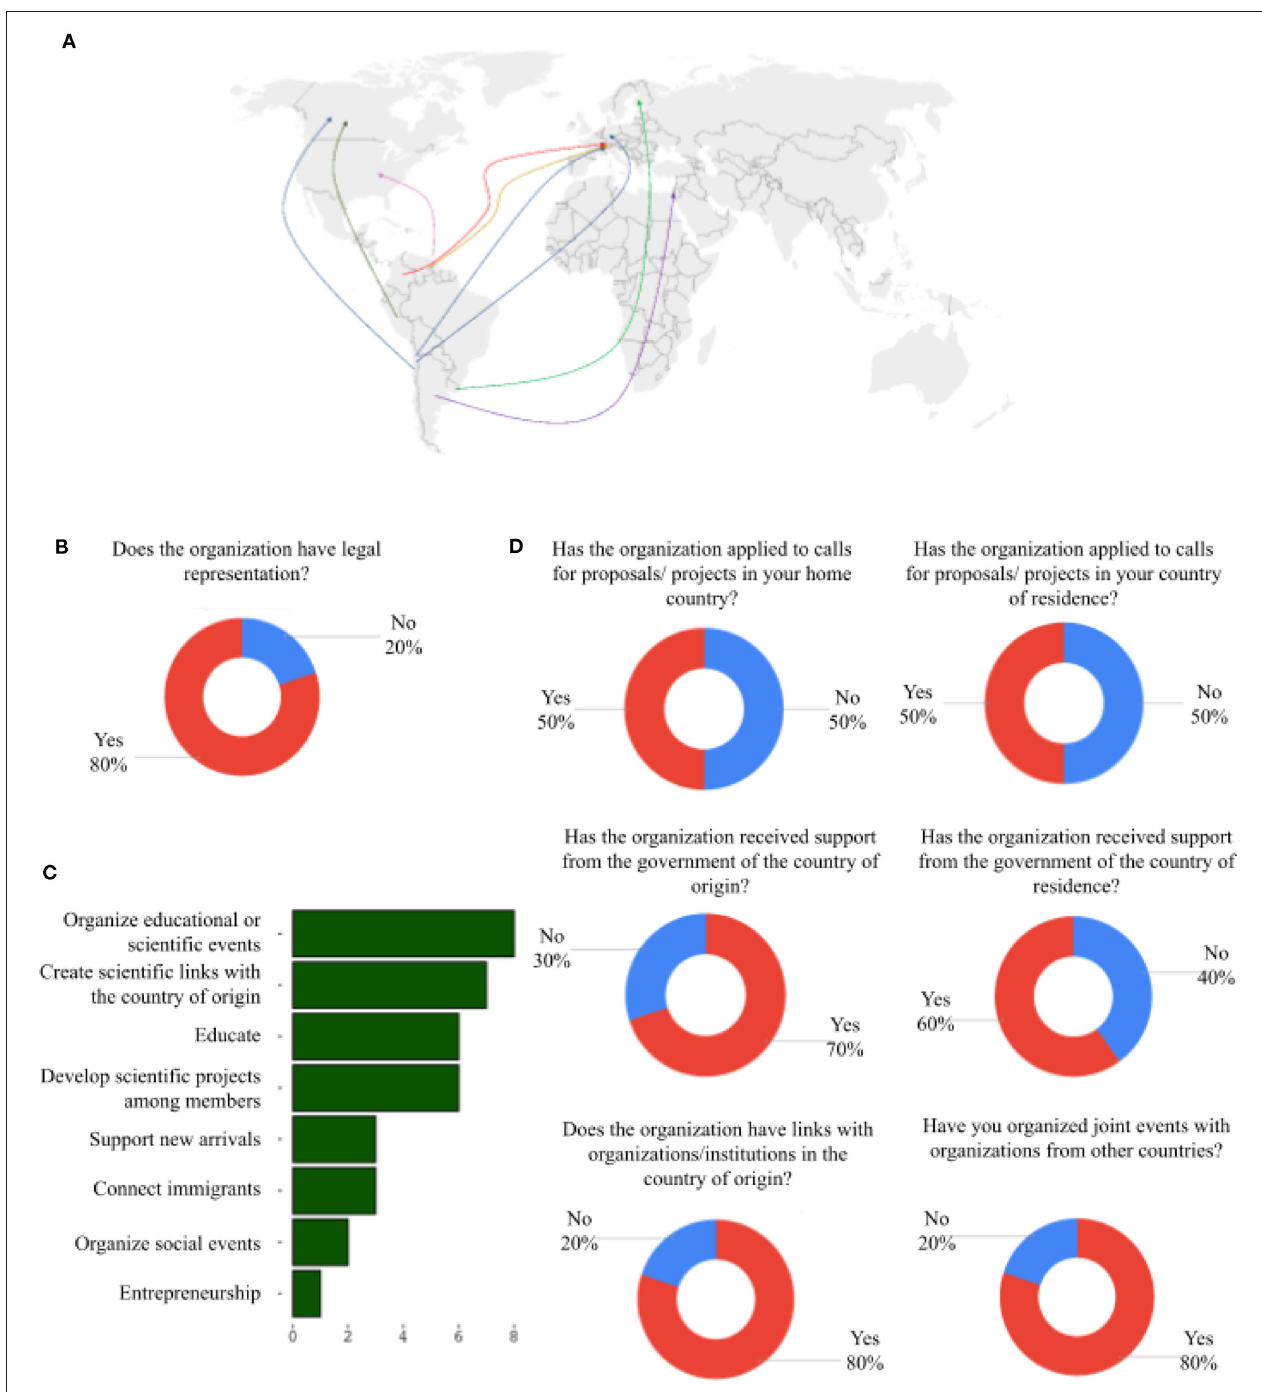
FIGURE 1 | Analysis of diaspora networks. (A) The 10 countries of origin and countries of residence of the diaspora networks that answered the survey (see Table 2 ). (B) Proportion of diaspora networks with legal representation. (C) Frequency of objectives stated by the diaspora networks surveyed ( n = 10). (D) Relationship of diaspora networks to their country of origin and their country of